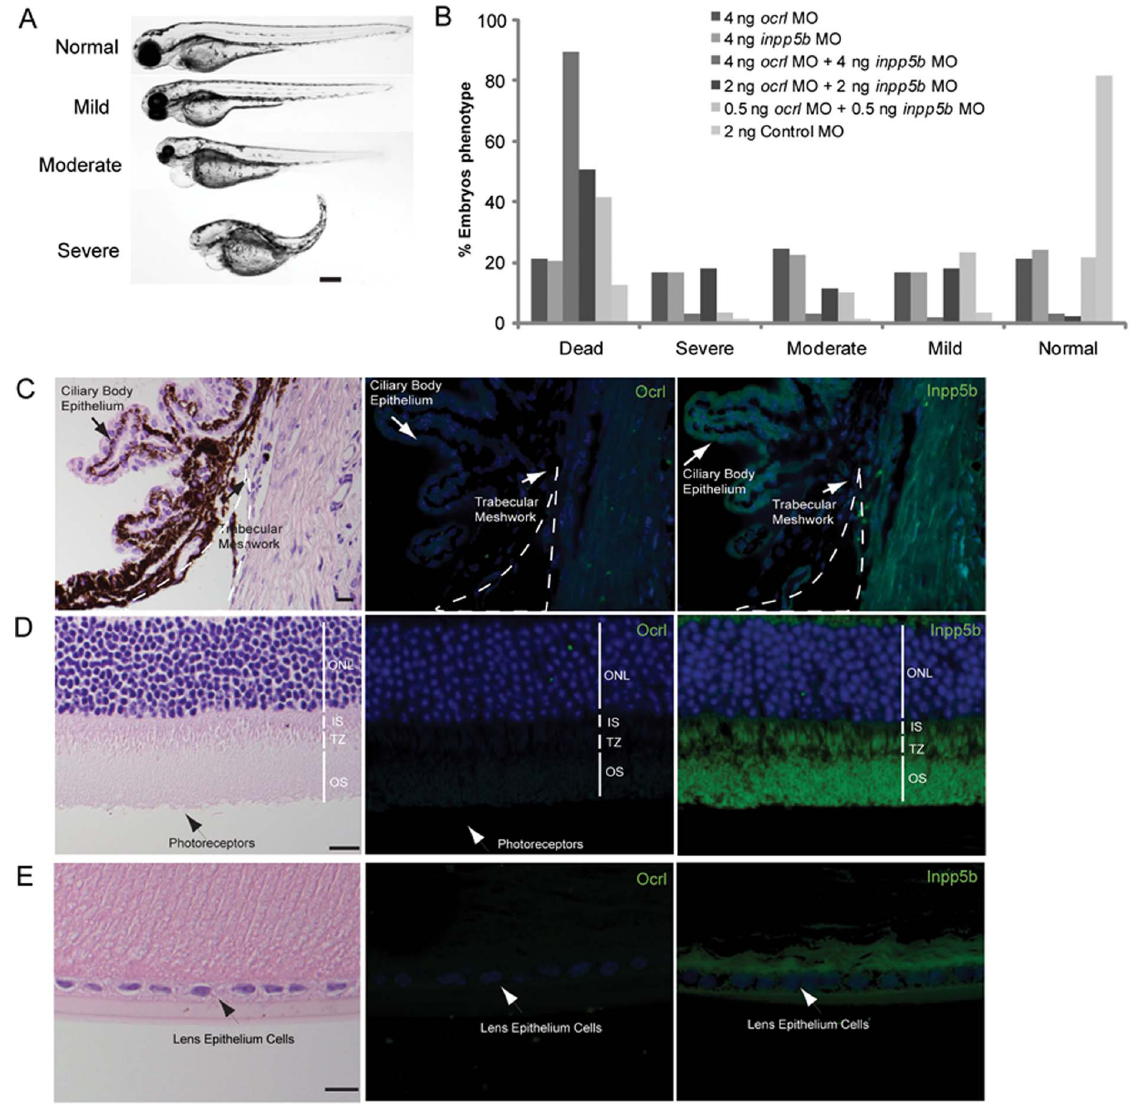
Figure 6. INPP5B and OCRL act synergistically in eye development. (A) Representative phenotypes of morphants co-injected with ocrl and inpp5b MO. Scale bar 250 micron. (B) Dose-dependent effect of two morpholinos in zebrafish. Control ocrl and inpp5b MO at indicated doses were injected into zebrafish embryos, and different grades of phenotypes were quantified at 48 hpf (N . 250 embryos per group). (C) Transgenic mOcrl 2 / 2 :mInpp5b 2 / 2 :hINPP5B + / + mouse eyes were sectioned and stained by H&E, anti-OCRL antibody (green) or anti-INPP5B antibody (green), and DAPI (blue). Staining of trabecular meshwork cells in vesicular pattern (arrow), dash line indicates border of cornea and iris. Scale bar 10 micron. (D) Photoreceptor cells (arrow) from the transgenic mouse eye section stained with H&E, anti-OCRL antibody (green) or anti-INPP5B antibody (green), and DAPI (blue). Scale bar 10 micron. (E) Lens epithelial cells (arrow) stained with H&E, anti-OCRL antibody (green) or anti-INPP5B antibody (green), and DAPI (blue). Scale bar 10 micron.